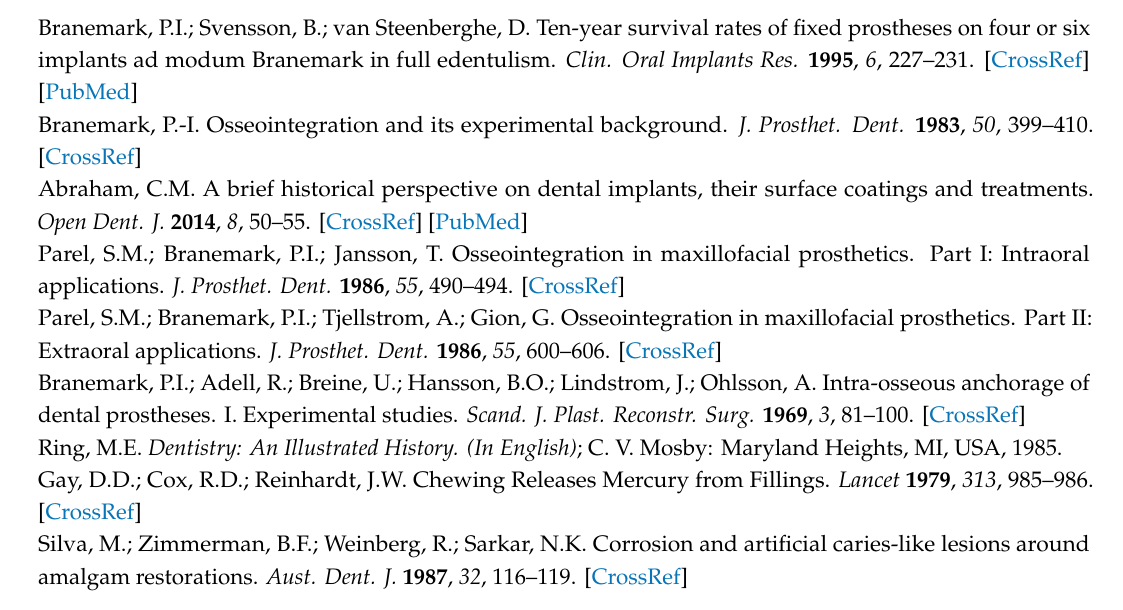
Table S1: Titanium calibration intensity avg, Table S2: Blank test solutions used in experiment intensity avg, Table S3: Solutions from soaking Ti rods only (no amalgam) intensity avg, Table S4: Solutions from soaking Ti rods with amalgam intensity avg, Table S5: Final wash of ICP-MS to demonstrate the memory e ff ect of